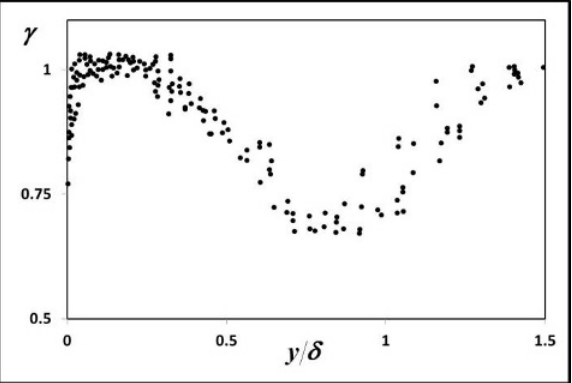
Fig. 11. Profile of the intermittency factor across turbulent boundary layer in grid generated